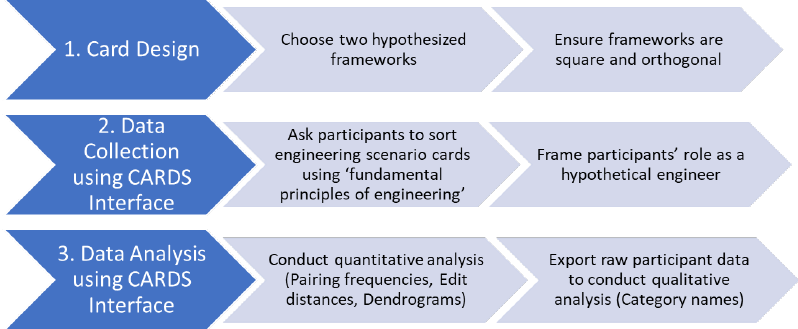
Fig. 1. Diagram of overall study